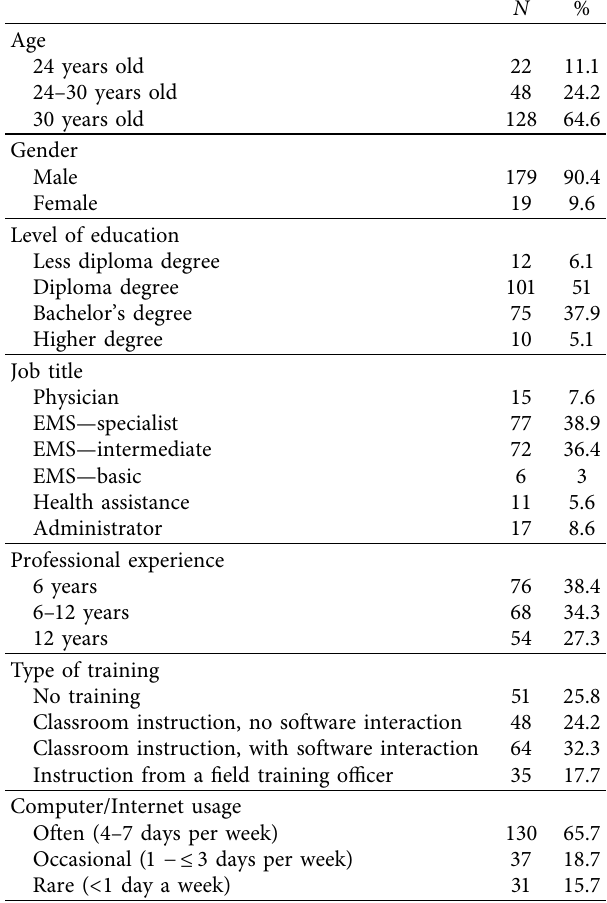
Table 1: Demographic characteristics of participants. ( N �